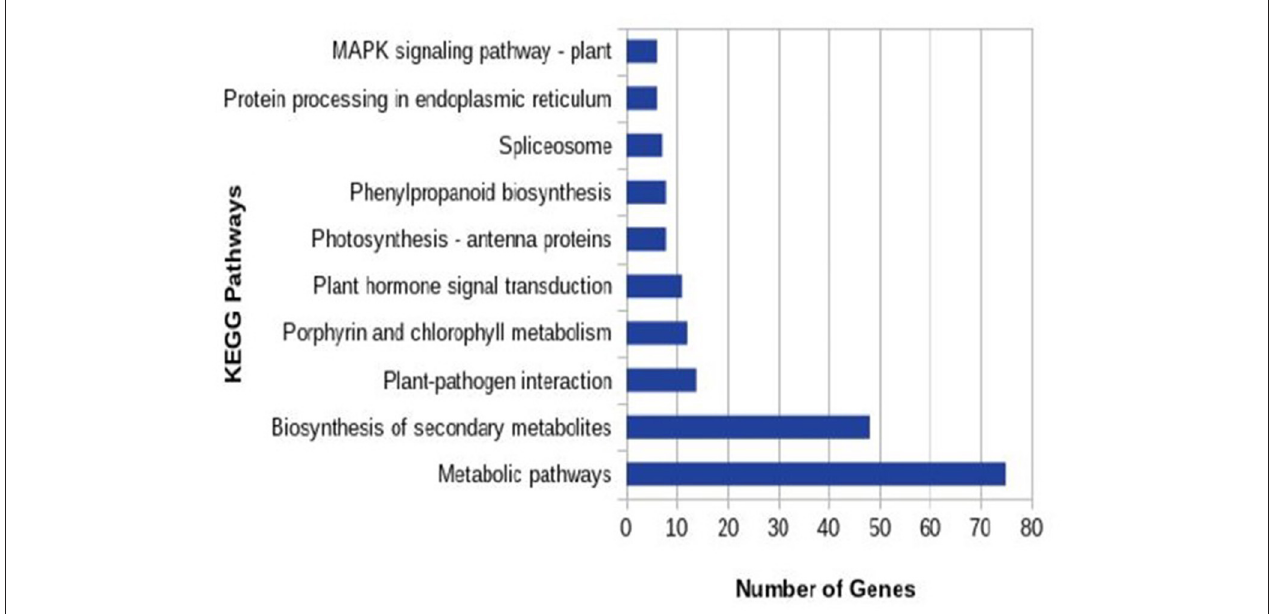
FIGURE 5 | Column graph representing the enriched Kyoto Encyclopedia of Genes and Genomes (KEGG) pathways based on the upregulation of DEGs in Cg-2 treated plants in comparison to untreated (control).